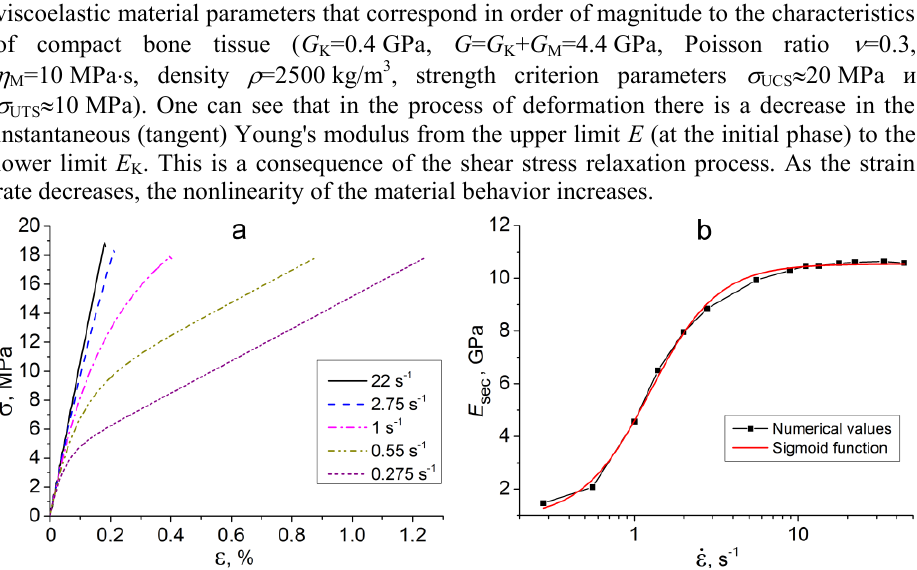
Fig. 3. Numerical diagrams of uniaxial compression of the model viscoelastic sample at different strain rates (a) and the dependence of effective (secant) Young’s modulus of the sample on the strain rate (b). Points in (b) are numerically obtained values; the solid curve is approximating sigmoid